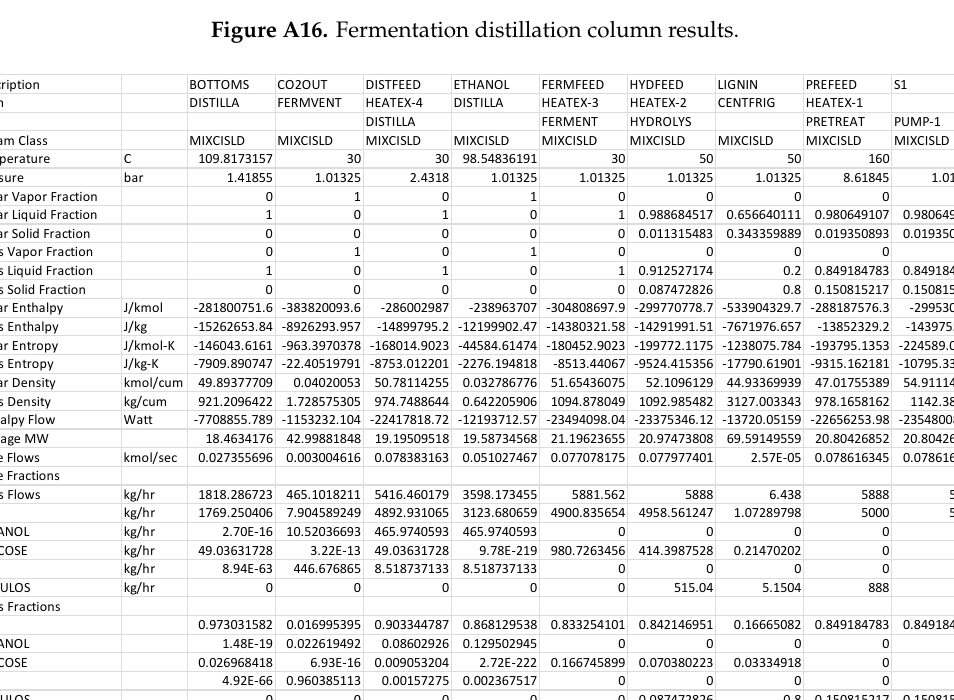
Figure A18. Fermentation stream results (part 2). References 1.